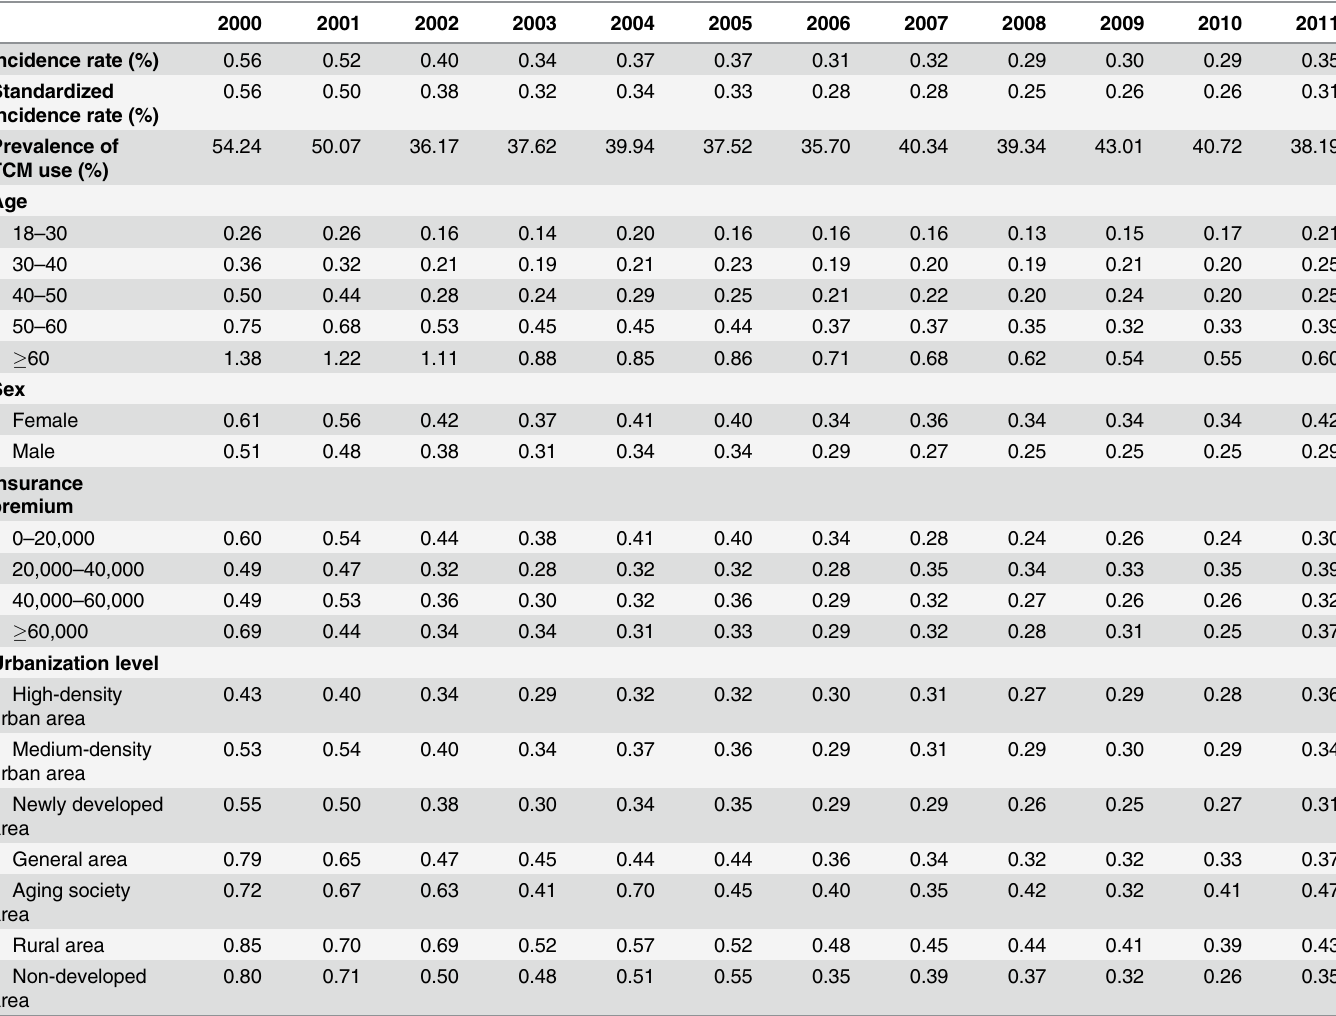
newly developed areas, general areas, aging society, rural areas, and undeveloped areas, respec- or greater than 0.91 [16] and a moderate or weak association as a RR of less than 3 or greater than 0.33 [17], the magnitude of association for age group of (cid:1) 60 years was strong, for sex and insurance premium level was trivial, and for calendar year, and urbanization level was weak. Annual asthma incidence rates in adults fluctuated rather than followed a linear trend. Thus, considering time as an ordinal variable, we did not observe a significant annual increase in the incidence rate. The incidence rates among male adults were lower (RR: 0.80, 95%